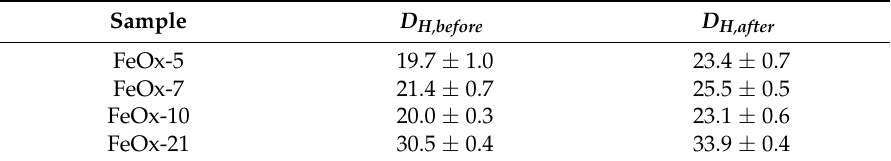
Table 5. Average particle/cluster hydrodynamic diameter before and after thermally induced aggregation in the temperature range from 25 ◦ C to T onset − 1, measured and calculated for dispersions with 1 g L − 1 concentration of polymer. The D H before and after are different with a significance value of